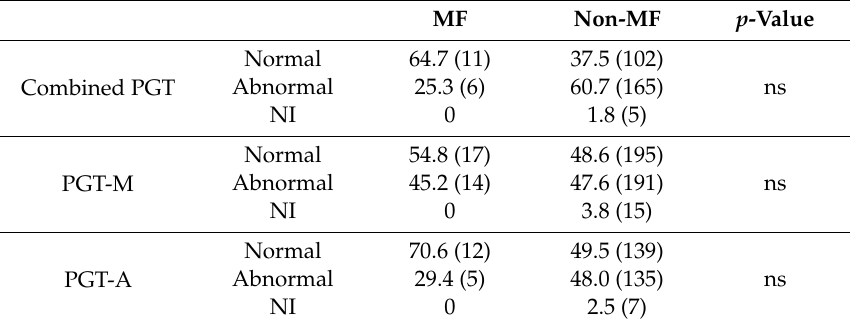
Table 5. Comparison of results per embryo in MF and non-MF groups (% (n)).